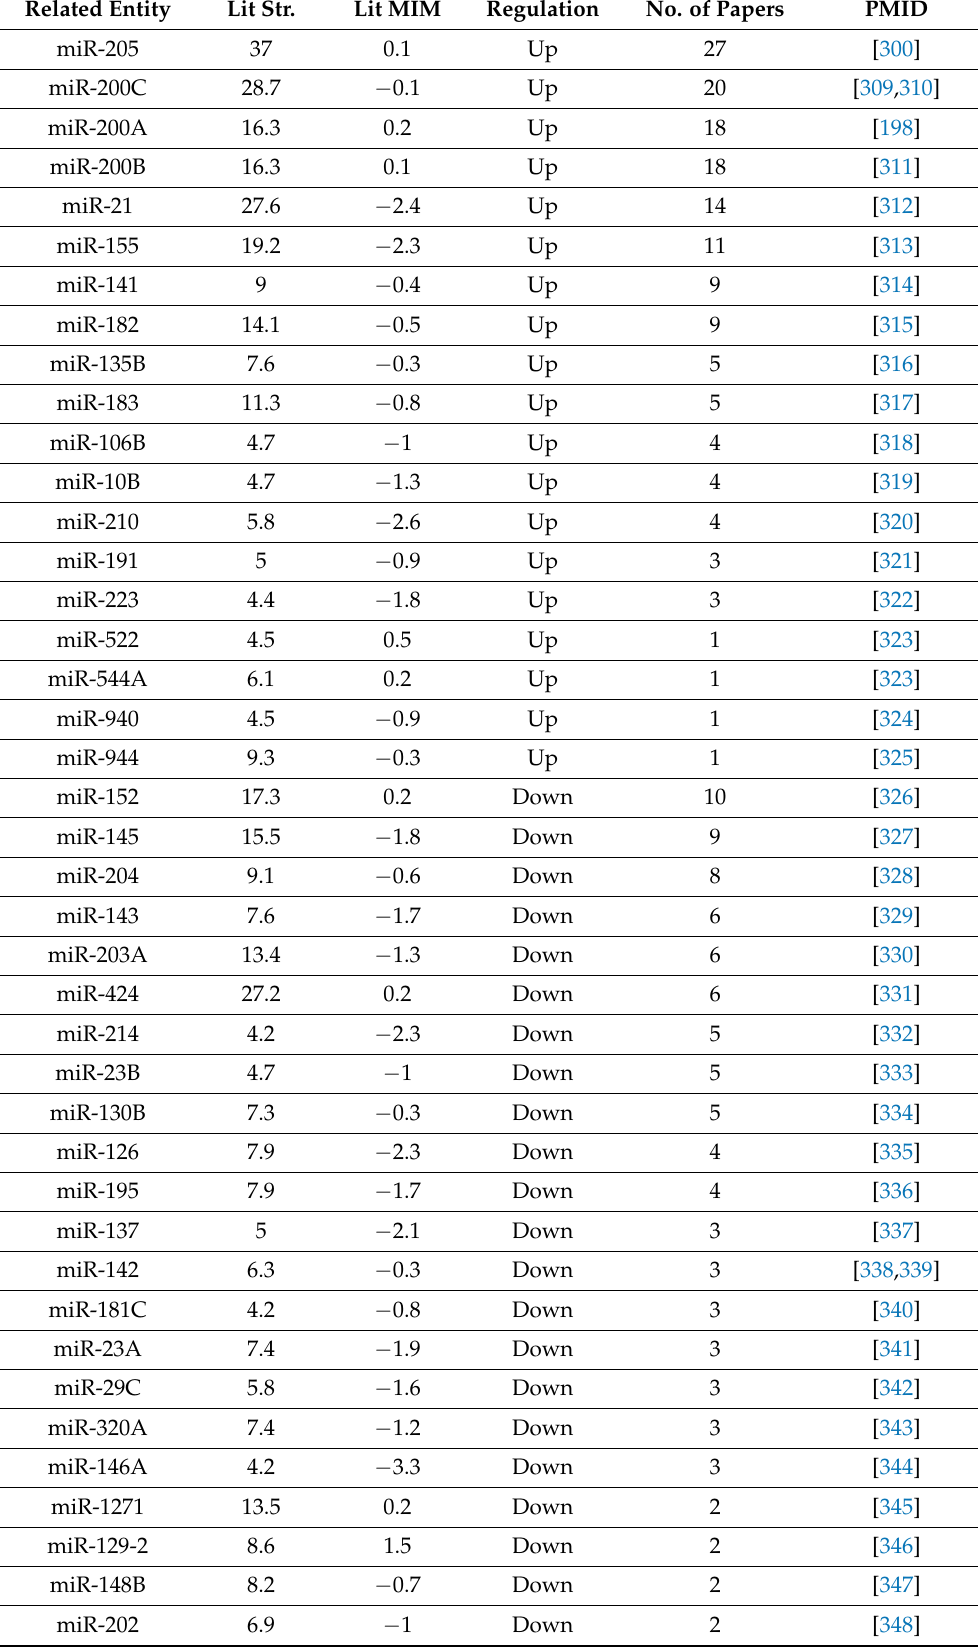
Table 3. Deregulated miR in Endometrial